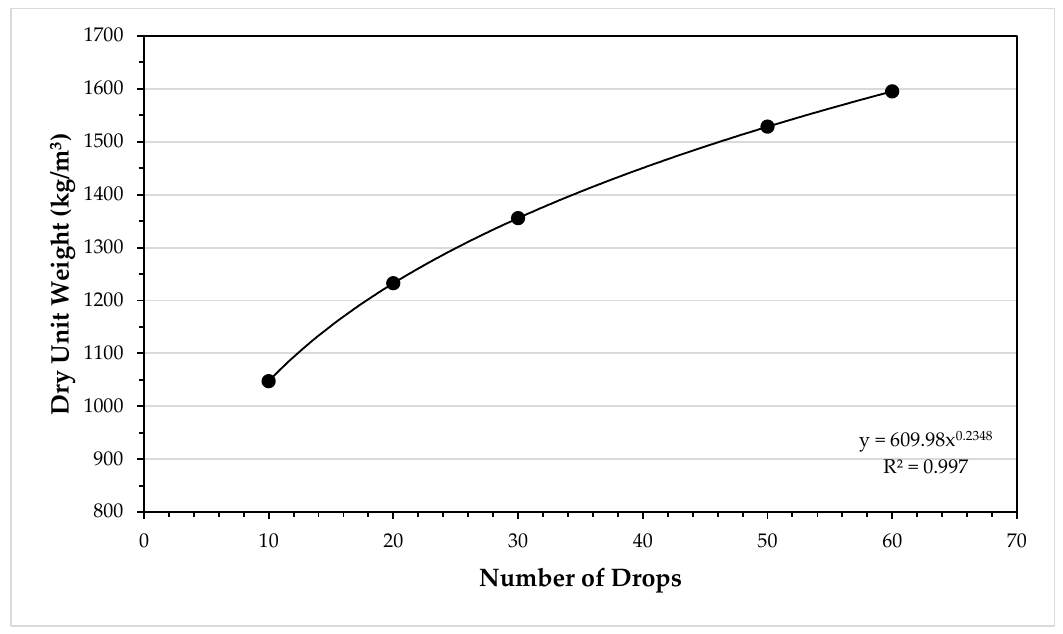
Figure 3. Number of drops with a hand tamper in relation to dry unit weight.